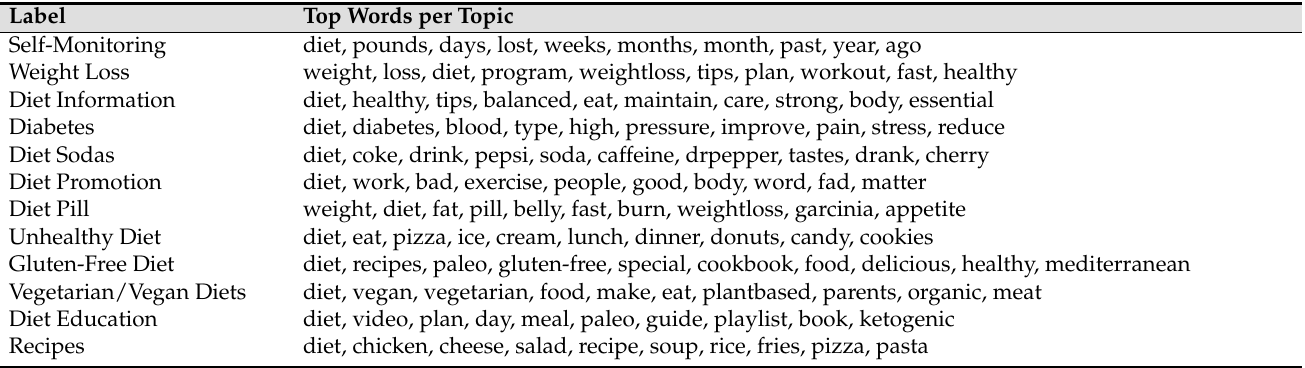
Table 1. A total of 41 topics extracted from the tweets by the LDA methodology. Label Top Words per Topic